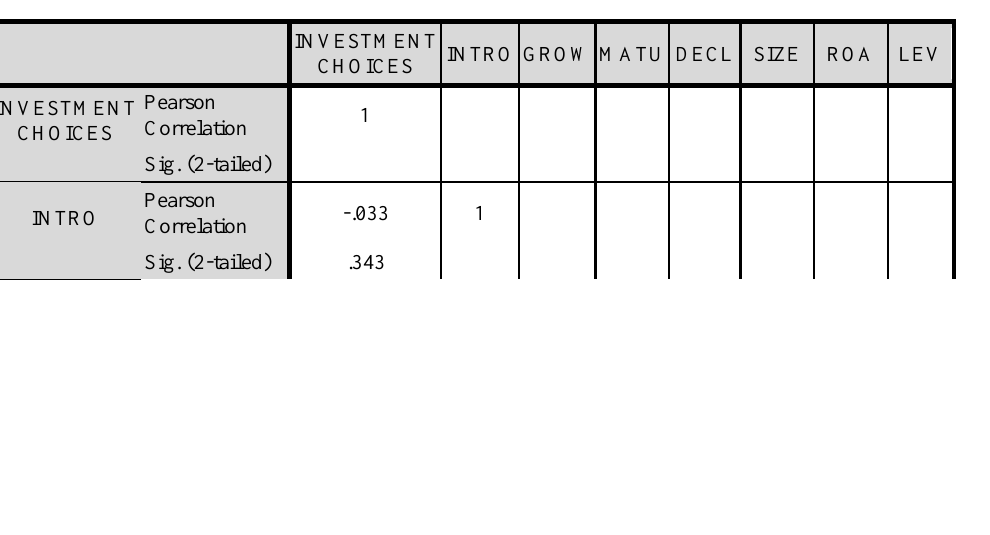
Table 2. The result of the Pearson correlation test of the research